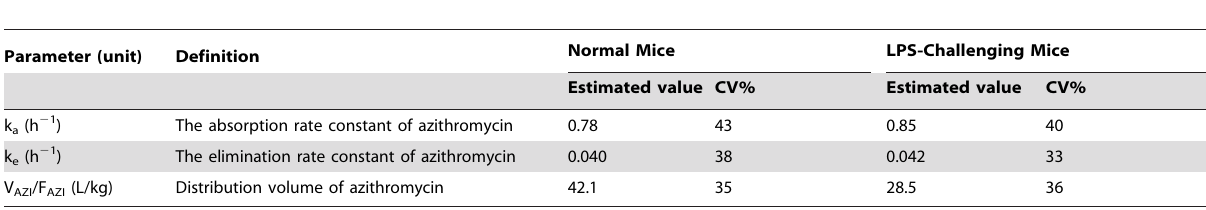
Table 1. The Pharmacokinetic Parameters of Azithromycin in Normal Mice and LPS-Challenging Mice.